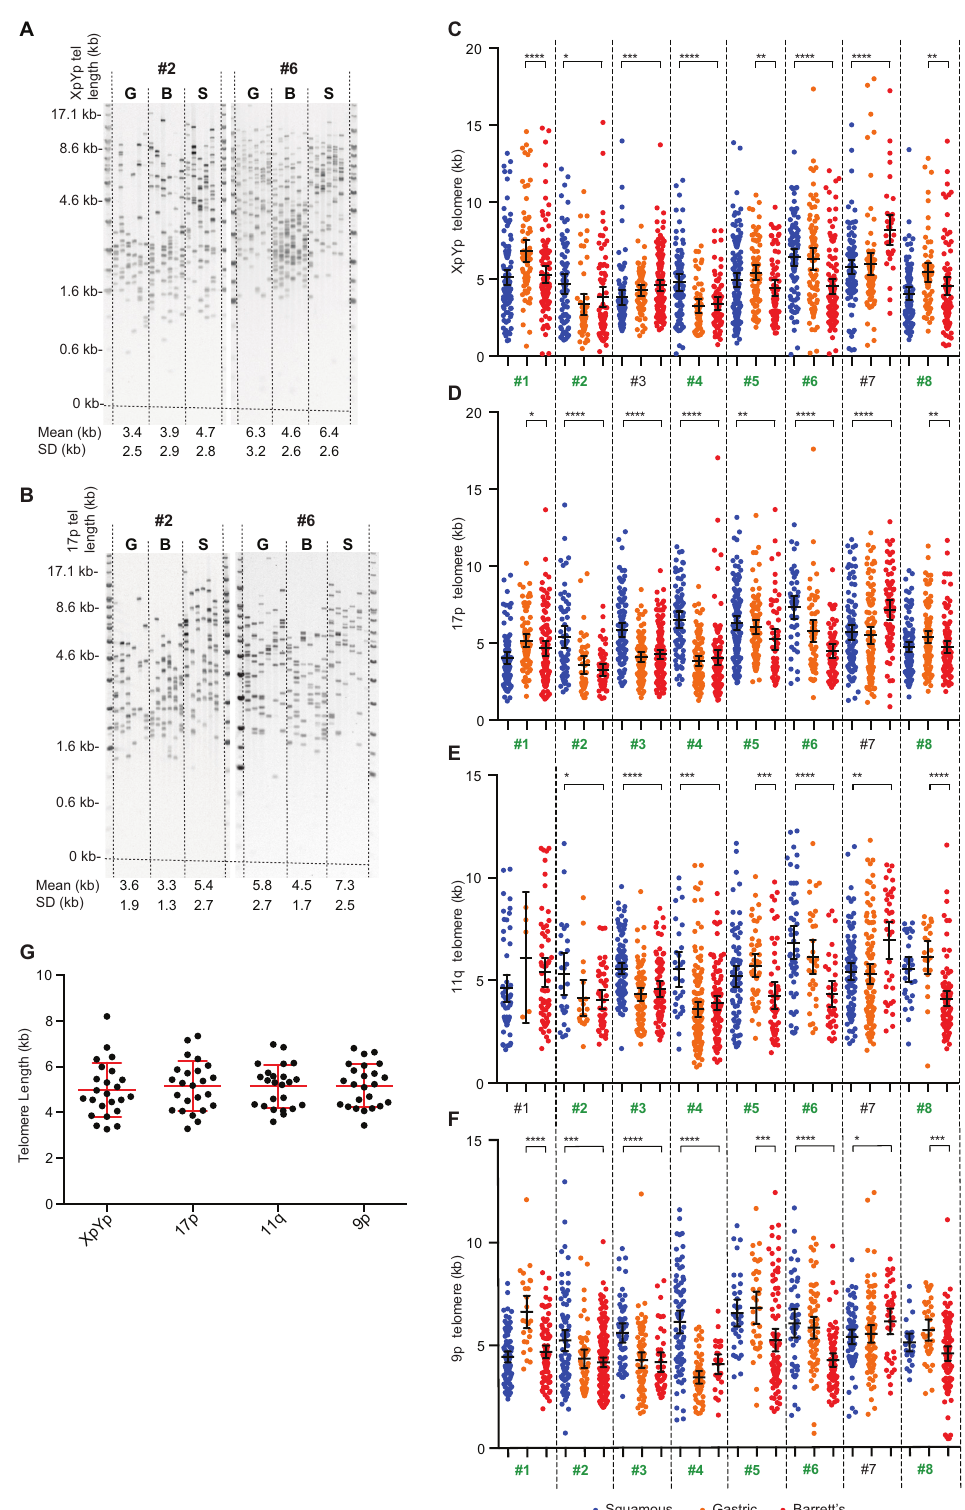
Fig 1. Shorter telomere length profiles are observed in Barrett’smetaplasia but no differences are detected at four different chromosome ends. A, an exampleof STELA at the XpYp telomerein two patients